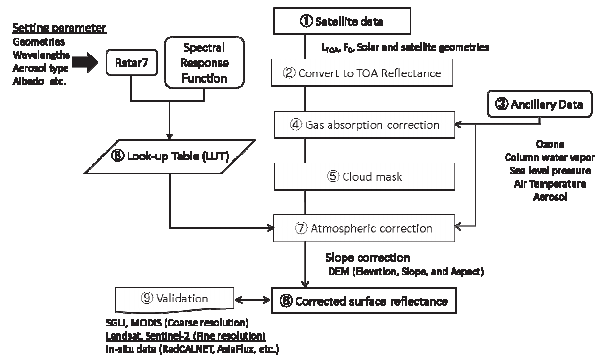
Figure 6. Atmospheric corrected image processing flowchart network is now creating in Kanto district as indicated by red